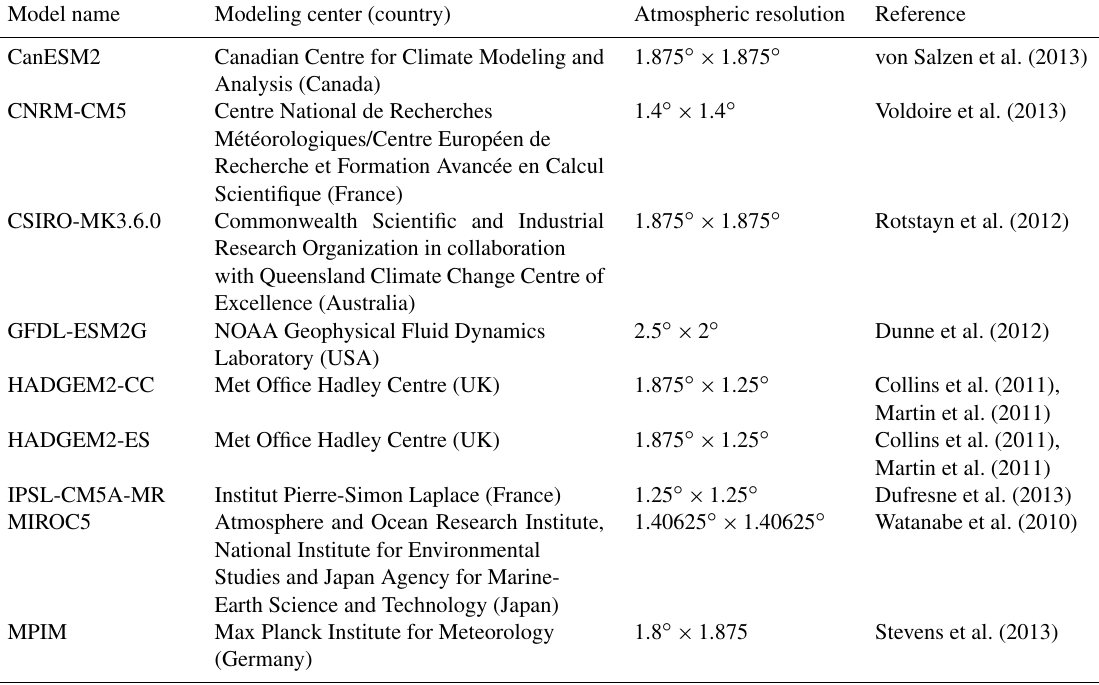
Table 1. Selected GCMs from the IPCC Data Distribution Center: model name, modeling center, atmospheric resolution and main reference. Source: IPCC